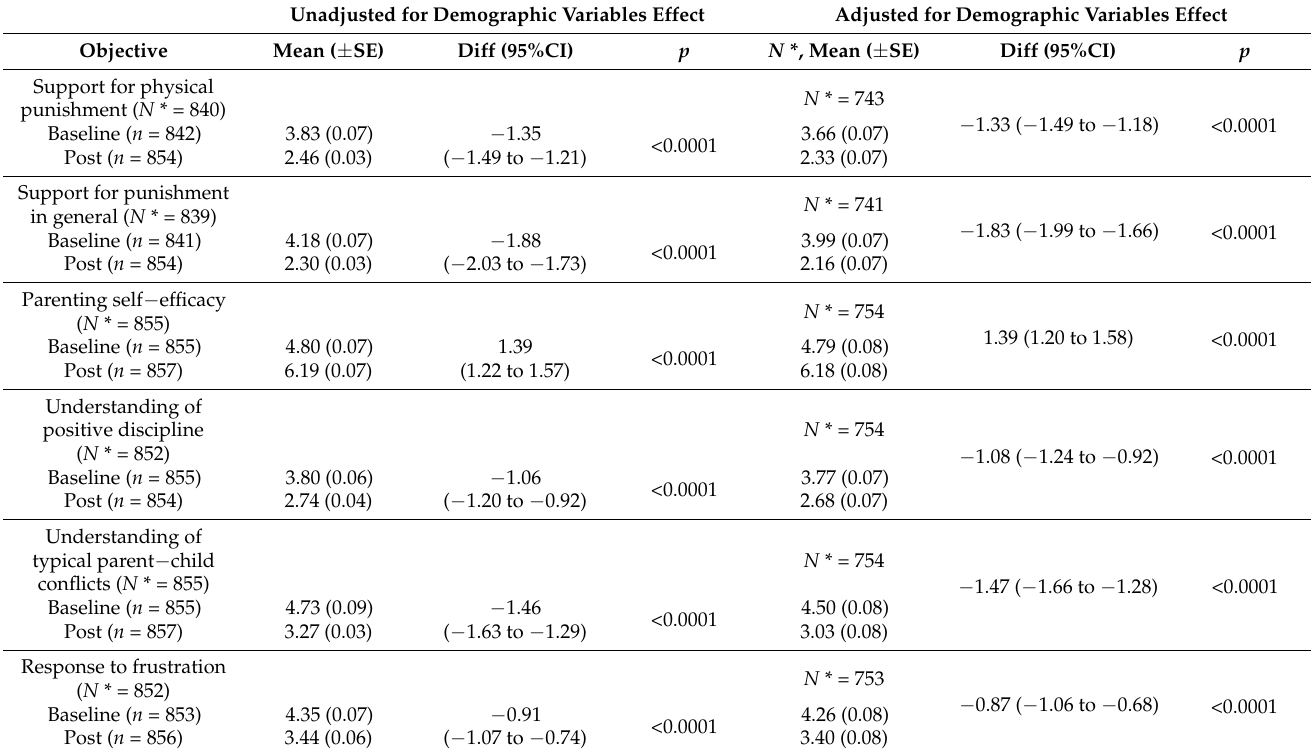
Table 3. Pre- and posttest means and